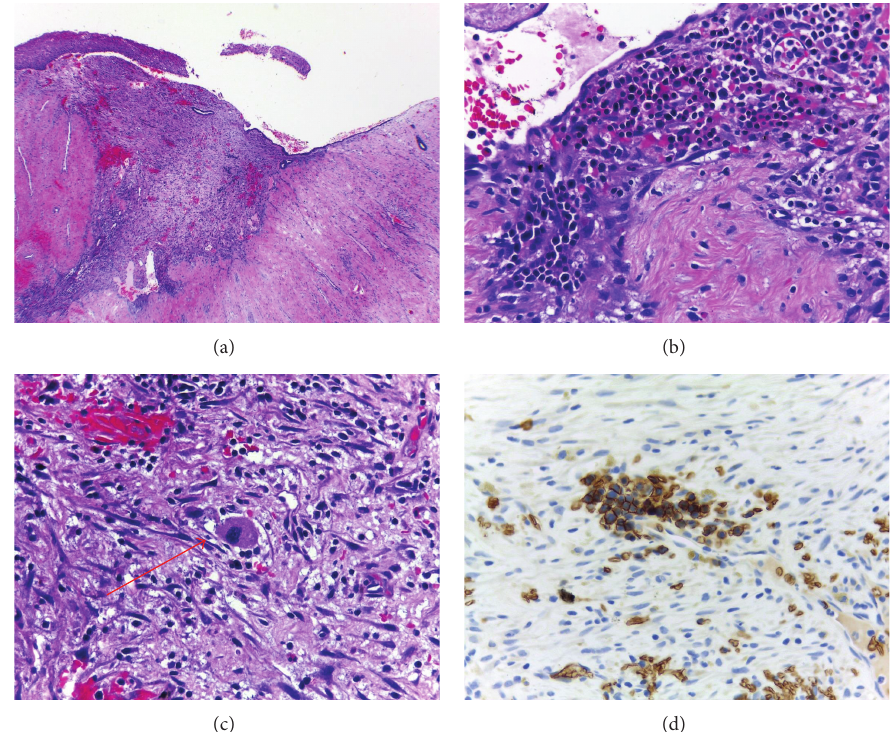
Figure 1: Microscopic appearance of the uterine cervix showed granulation tissue at squamocolumnar junction consistent with previous biopsysite(a).Clustersoferythroidprecursors(b)andamegakaryocyte((c),arrow)embeddedingranulationtissue.Theerythroidprecursors were highlighted by glycophorin C